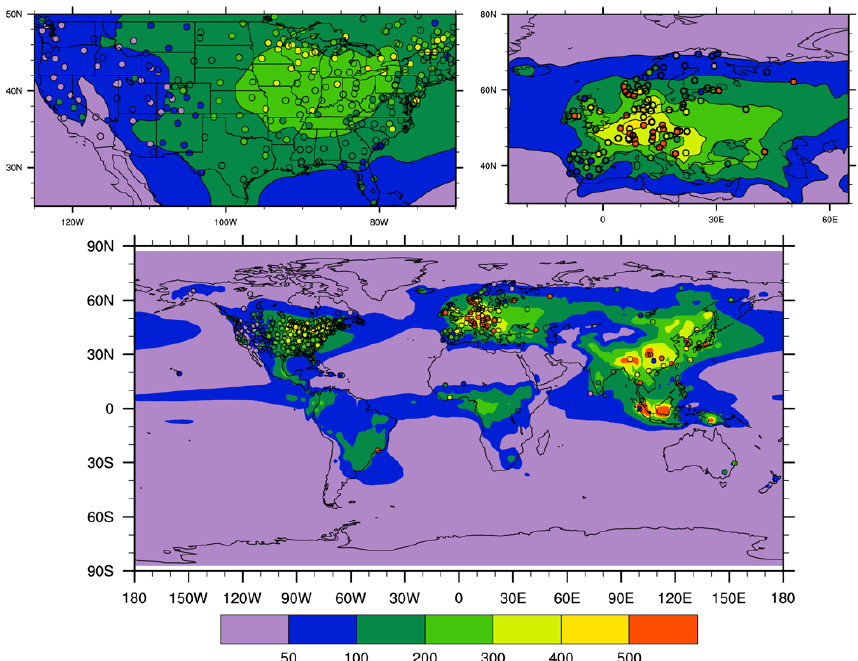
Fig. 1b. Ammonium wet deposition (mg(N)m − 2 yr − 1 ) for 2000. Contours are for the multi-model mean; filled circles are for the wet deposition network